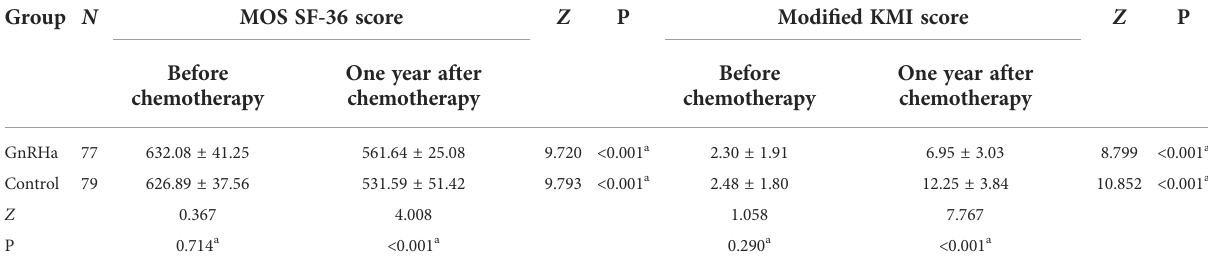
TABLE 7 Comparison of the MOS SF-36 score and the modi fi ed KMI score between the two groups before chemotherapy and one year after chemotherapy. Group N